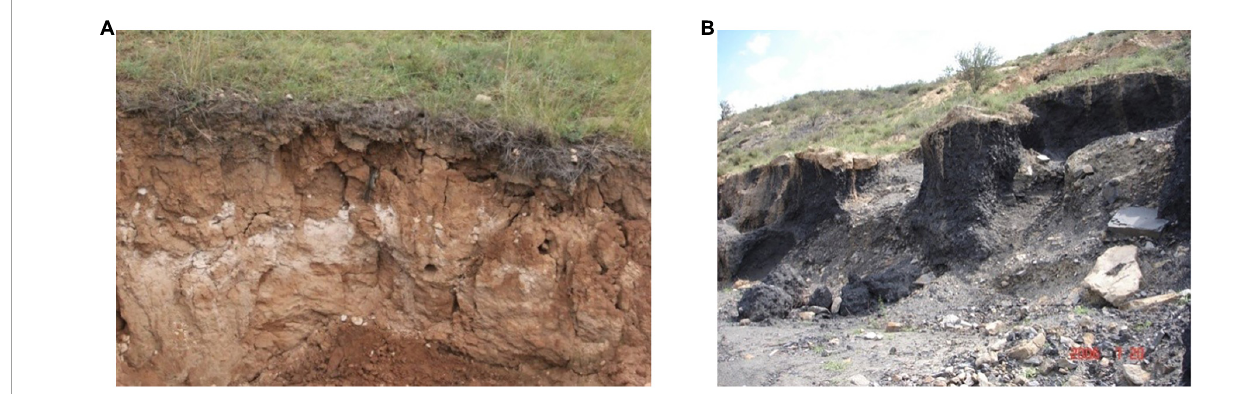
FIGURE4 Soil comparison before and after mining. (A) Original soil; (B) damaged soil.